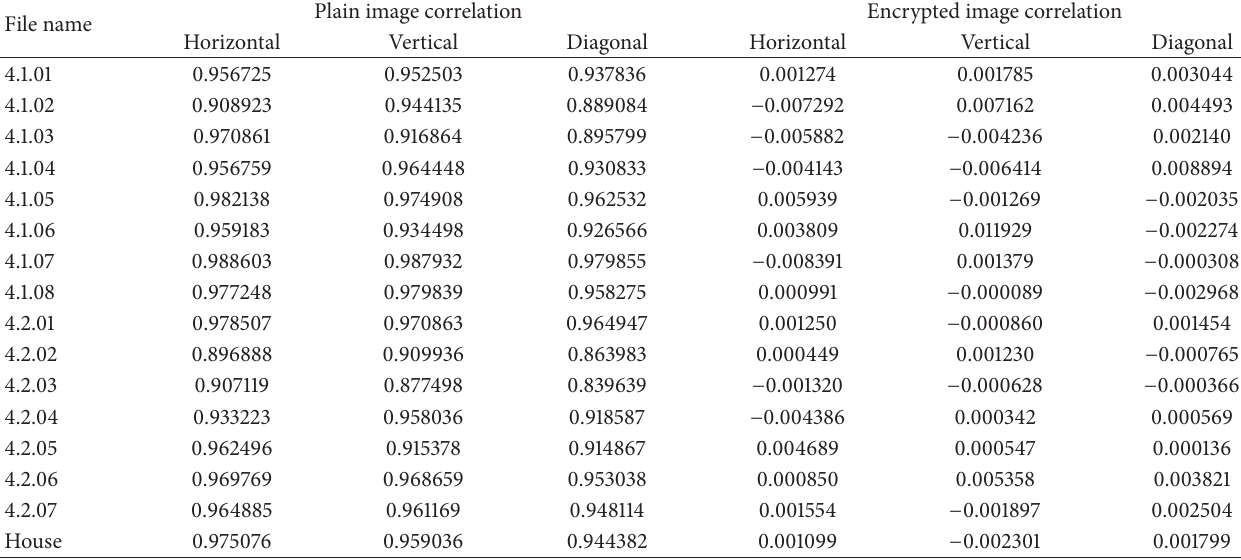
Table 6: Horizontal, vertical and diagonal correlation coefficients of adjacent pixels in plain images and encrypted images.